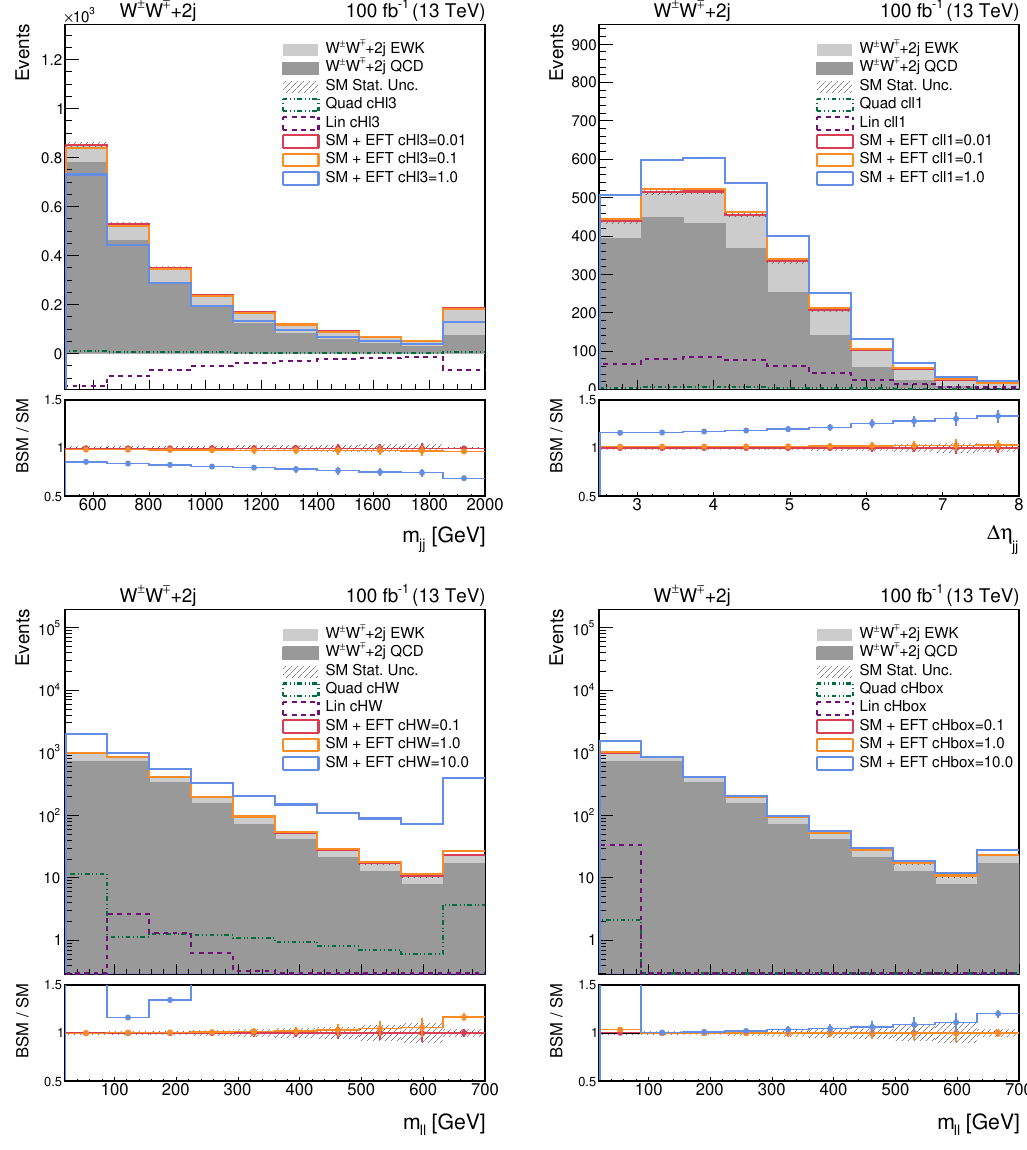
Figure 13 . Comparison of SM (filled histograms) and BSM (lines) expected number of events after the event selection in table 4, for various observables and Wilson coefficients in the OSWW+2j-EW and OSWW+2j-QCD processes, at an integrated luminosity of 100 fb − 1 . The SM distribution is represented as a stacked histogram, summing EW (light grey) and QCD (dark grey) components. Solid lines show the total prediction for one Wilson coefficient at a time, with c 0 . 1 (orange) or 1 TeV − 2 (blue). The pure interference (quadratic) EFT component, normalized to c α / Λ 2 = 1 TeV − 2 , is indicated with a purple (green) dashed line. For all distributions, the last bin comprises all the overflow